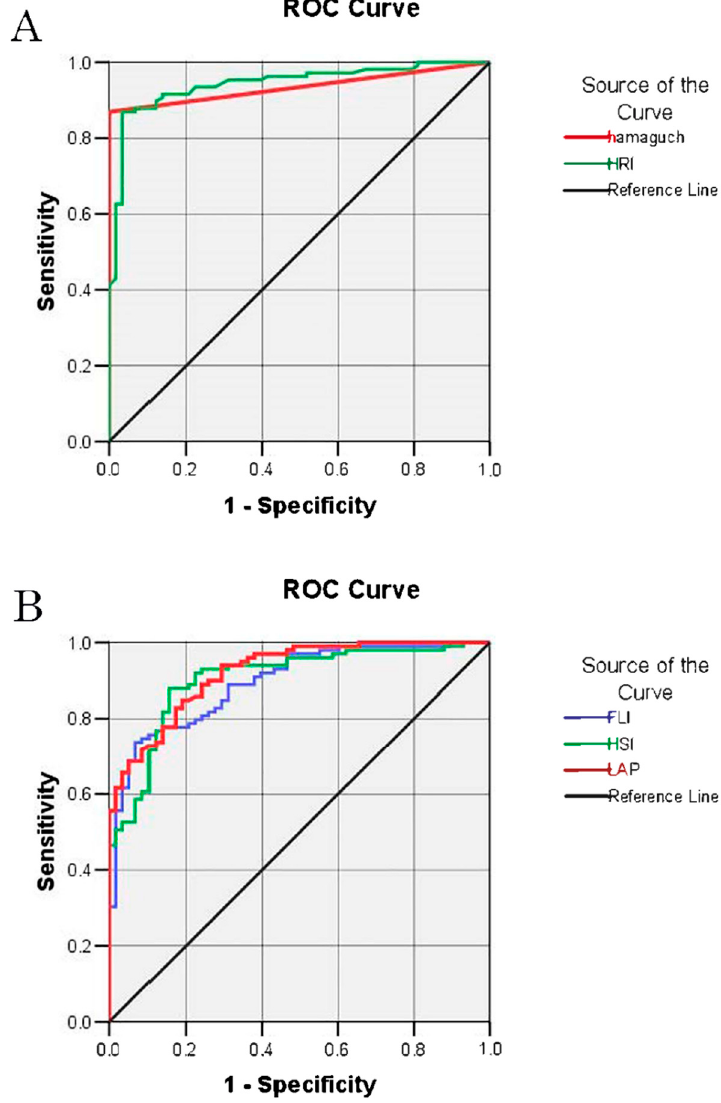
Figure 3. The receiver-operating characteristic (ROC) curve for the detection of non-alcoholic fatty liver disease (CAP > 234) for ultrasound-based (A) and non-imaging (B) methods. Abbreviations: CAP, controlled attenuation parameter; HRI, hepatorenal index; HSI, hepatic steatosis index; FLI, fatty liver index; LAP, lipid accumulation product; ROC, receiver operating characteristic.